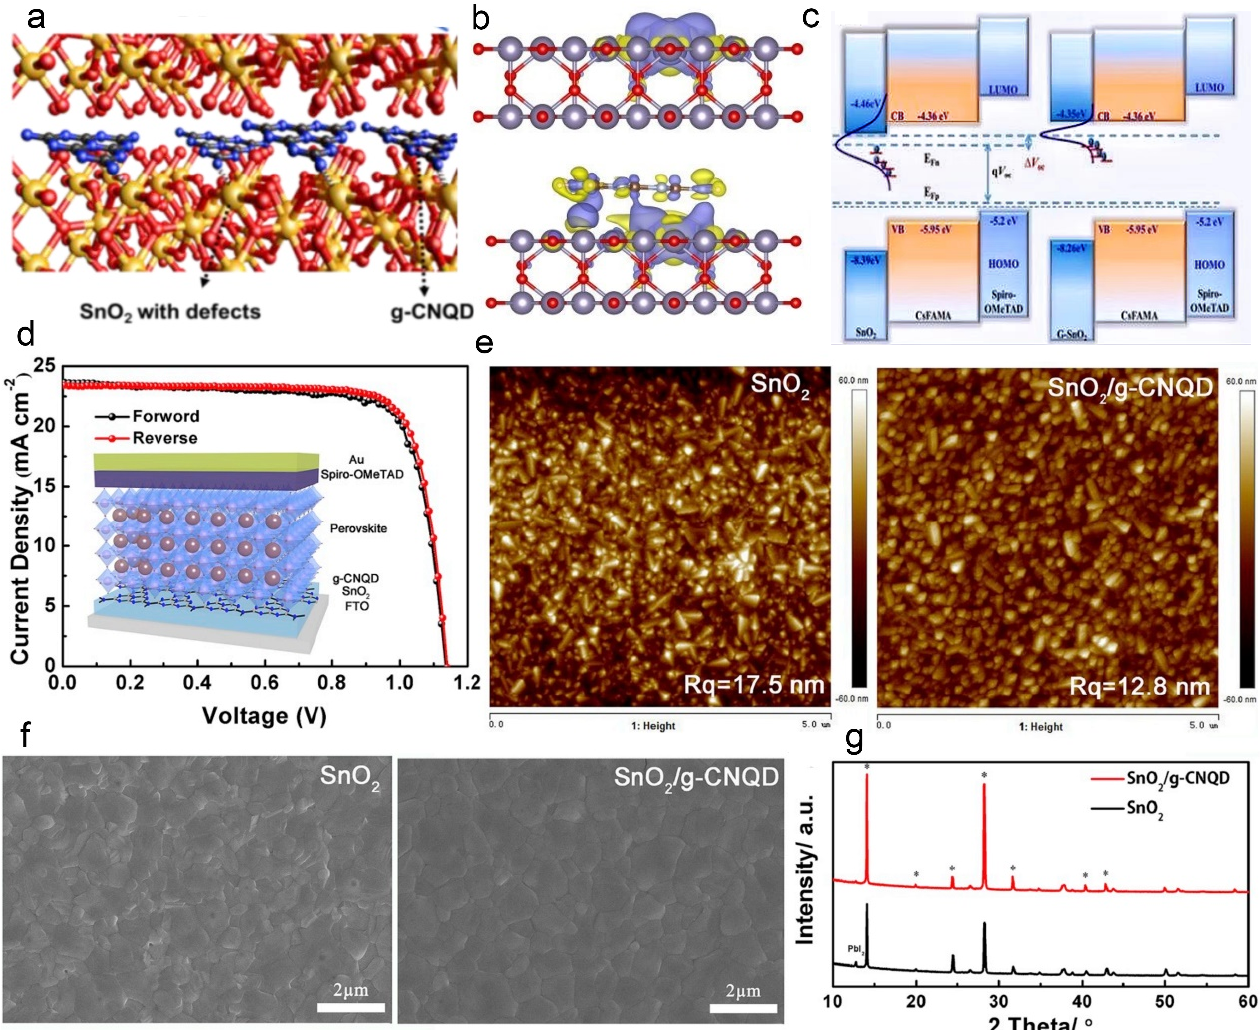
Figure 4. ( a ) The position of G–CNQD in SnO 2 . ( b ) The side view for the charge density difference of SnO 2 (above) and G–SnO 2 (below) with oxygen vacancy; the yellow and cyan areas indicate electron depletion and accumulation, respectively. ( c ) Energy band alignment of the devices (reproduced with permission [86]; copyright 2020, Royal Society of Chemistry). ( d ) Schematic illustration of the devices with a g–CNQD layer and a J–V curve. ( e ) AFM images of pristine SnO 2 film and SnO 2 /g–CNQD films. ( f ) SEM images and ( g ) XRD spectra of perovskite films based on different ETL. The asterisks indicate the main peaks of perovskites structure (reproduced with permission [91]; copyright 2020,